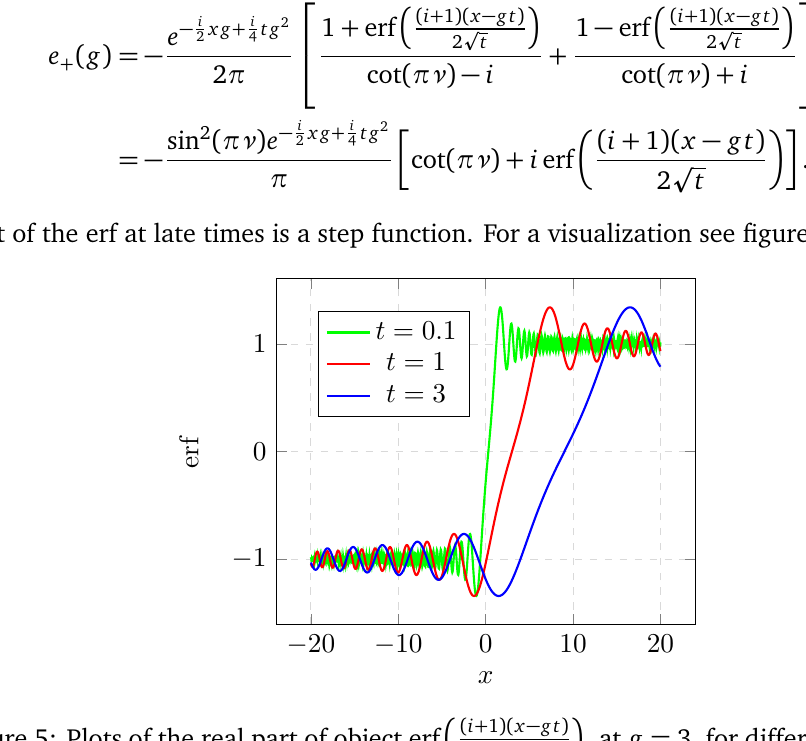
Figure 5: Plots of the real part of object erf t . The function approximates 2 θ ( x − gt ) − 1. As t → 0, the oscillations condense and the limit becomes exact. The imaginary part (not shown) oscillates around